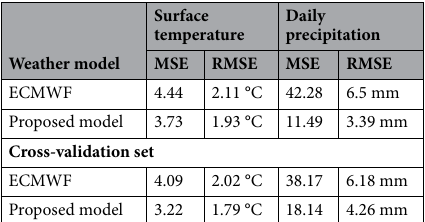
Table 5. Proposed model performance evaluation.